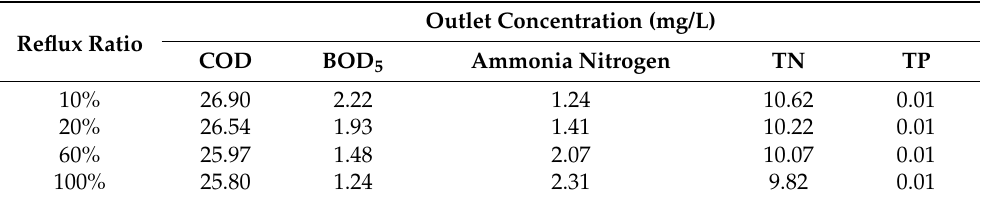
Table 2. The simulation of different reflux ratios in the CAST process.